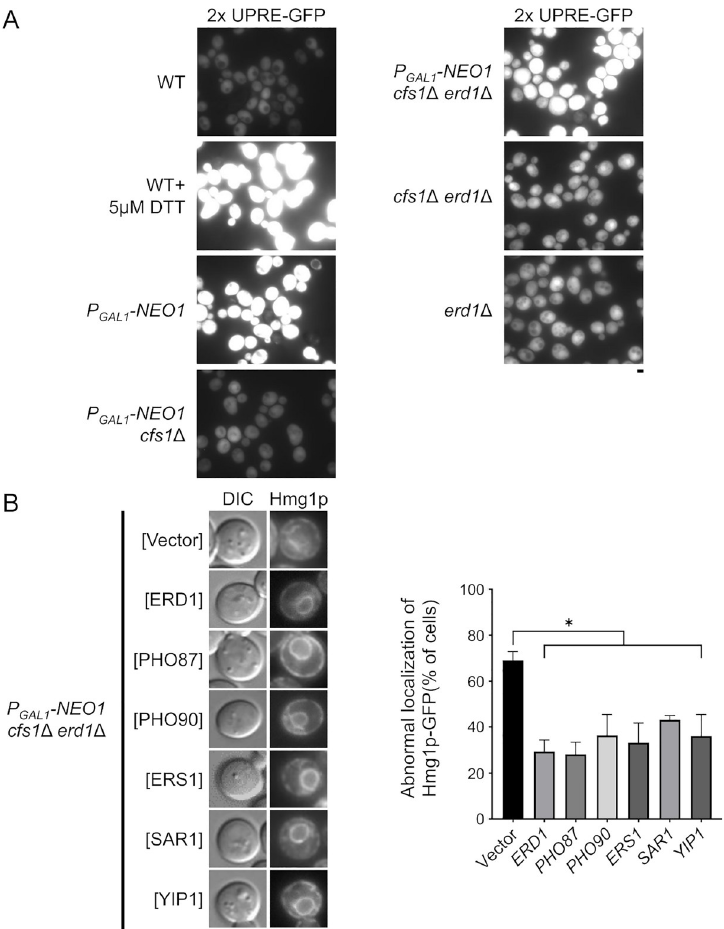
Fig 7. UPR is induced in the Neo1p-depleted cfs1 Δ erd1 Δ mutant. (A) Induction of UPR in the Neo1p-depleted cfs1 Δ erd1 Δ mutant. Yeast cells that express GFP under the control of 2 × UPRE were cultured in YPDA as in Fig 1C. For treatment of wild-type cells with dithiothreitol (DTT), early log phase cells equivalent to 1.5 ml culture of OD 600nm = 1.0 were collected and incubated in YPDA that contains 5 μ M DTT for 4 h. The strains used were WT (YKT2200), P GAL1 - NEO1 (YKT2201), P GAL1 - NEO1 cfs1 Δ (YKT2202), P GAL1 - NEO1 cfs1 Δ erd1 Δ (YKT2203), cfs1 Δ erd1 Δ (YKT2204), and erd1 Δ (YKT2205), all of which carry 2× UPRE-GFP . (B) Suppression of the abnormal localization of Hmg1p-GFP by the multicopy suppressors of the Neo1p-depleted cfs1 Δ erd1 Δ mutant. Cells were cultured in YPDA at 30˚C for 20 h. The strain used was the P GAL1 - NEO1 cfs1 Δ erd1 Δ (YKT2186) mutant, which contains HMG1 - GFP and multicopy suppressors, as in Fig 4B. Left panel : Representative cells are shown. Right panel : The percentage of cells with abnormal localization of Hmg1p-GFP was determined ( n = 200) and is expressed as the mean ± standard deviation of five independent experiments. An asterisk indicates a significant difference, as determined by the Tukey–Kramer test ( � : p < 0.01). Bar, 5 μ m. DIC, differential interference contrast.